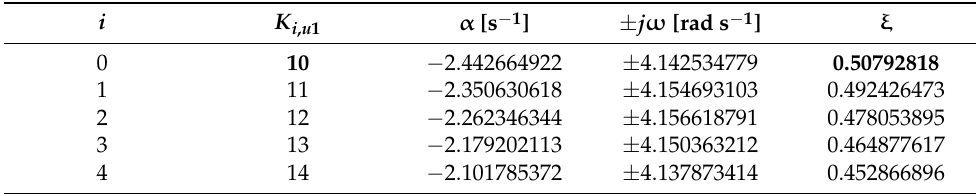
Table 6. Dominant oscillatory pole for PSS parameters T = 0.5 s, K i,um = 10–14, m = 1 ( upper cluster 1